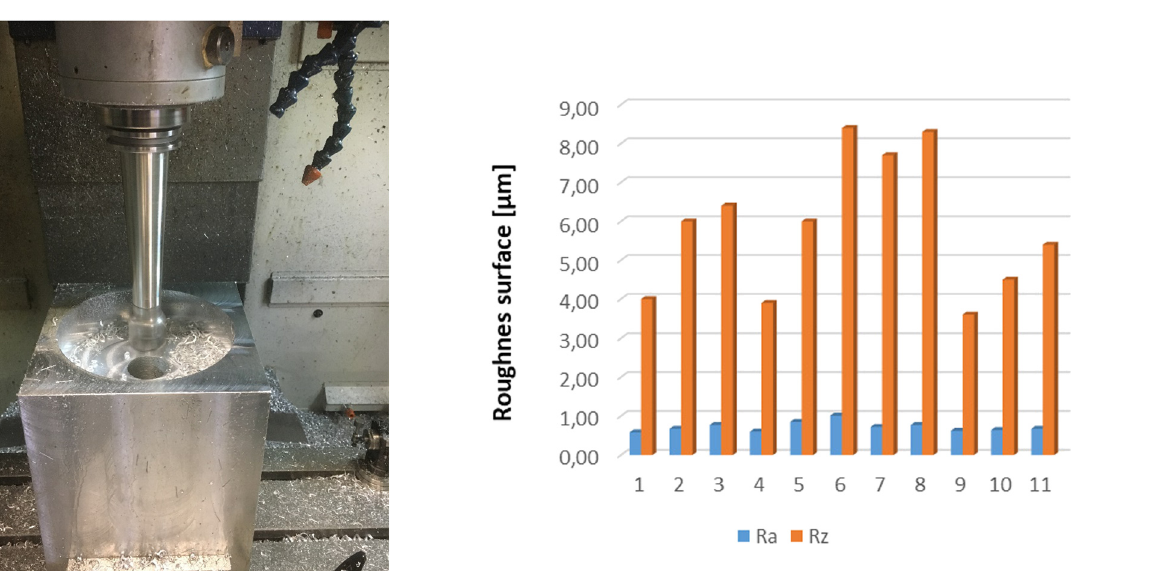
Figure 9: Roughness of the hole surface with diameter